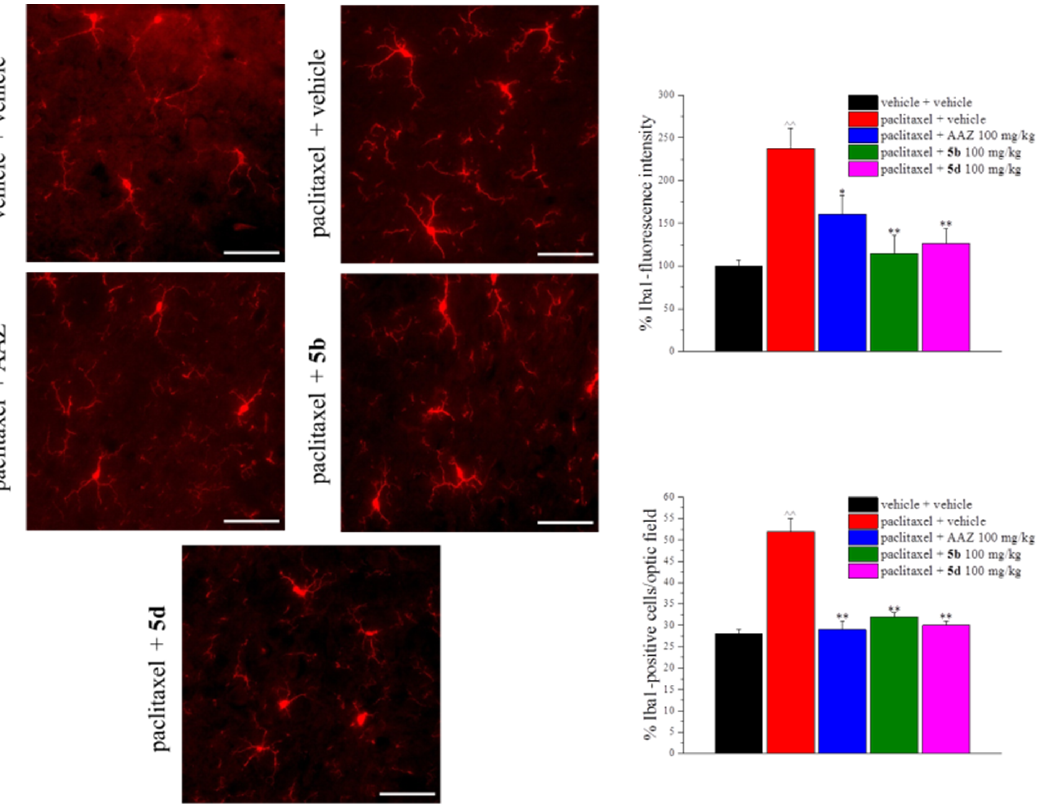
Figure 5. Effect of repeated CAI treatment on paclitaxel-induced microglia activation. Paclitaxel (2.0 mg/kg, i.p.) was administered on four days (1, 3, 5, and 8). Starting from the first day of paclitaxel injection and until the end of the experiment, 5b and 5d and AAZ were daily per os administered at 100 mg/kg. On day 15, at the end of the behavioral experiments, animals were sacrificed and the lumbar spinal cord was collected. The number of Iba1-positive cells was measured in the dorsal horn of the L4–L5 spinal cord. Transverse sections of the spinal cord imaged with a × 20 objective (scale bar = 50 µ m). Histograms show the quantitative analysis of Iba1 fluorescence intensity and the number of GFAP-positive cells/optic field. Data are expressed as the mean ± S.E.M. of values from eight mice analyzed in two different experimental sets. ˆˆ p < 0.01 vs. vehicle + vehicle; * p < 0.05 and ** p < 0.01 vs. paclitaxel + vehicle.